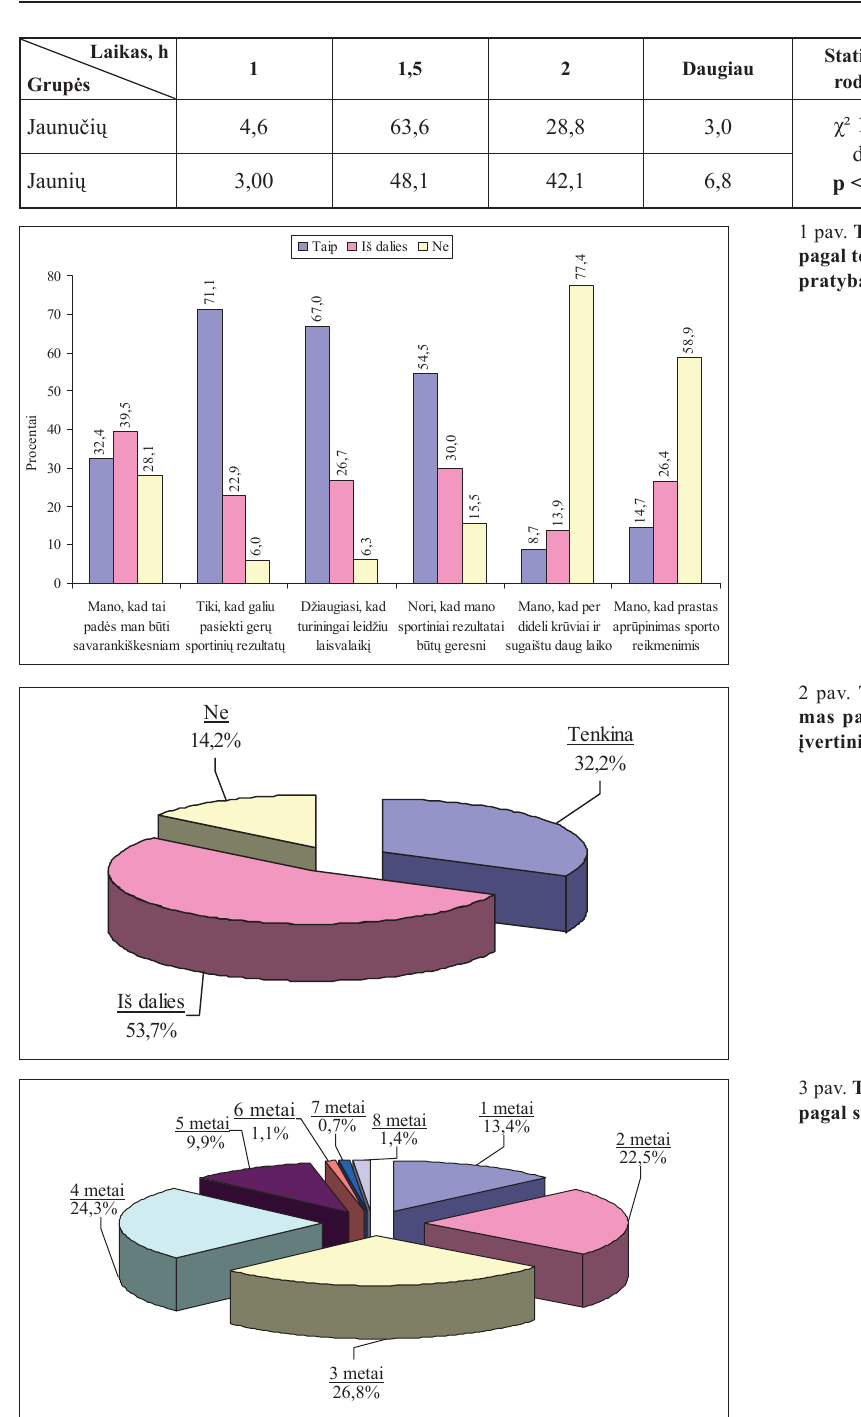
fi ziniai kr ū viai ir sugaištama daug laiko. Galima teigti, kad vaik ų užimtumo trukm ė t ė vams n ė ra svarbi, kai veikla turininga ir prasminga. 58,9% t ė v ų teigia, kad j ų vaikai yra pakankamai apr ū pinti sporto reikm ė